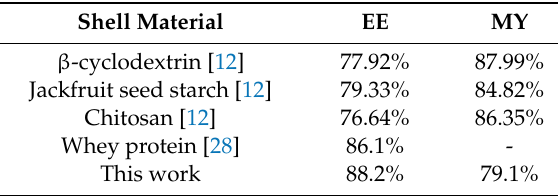
Table 1. The properties of microcapsules prepared with HBS were compared with those prepared with other shell materials.